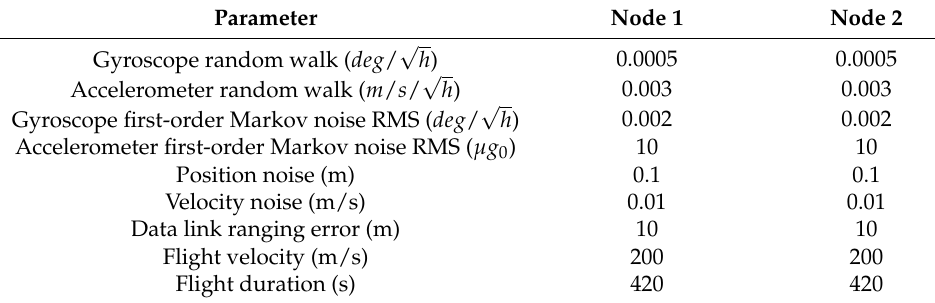
Table 2. LEO constellation parameters.